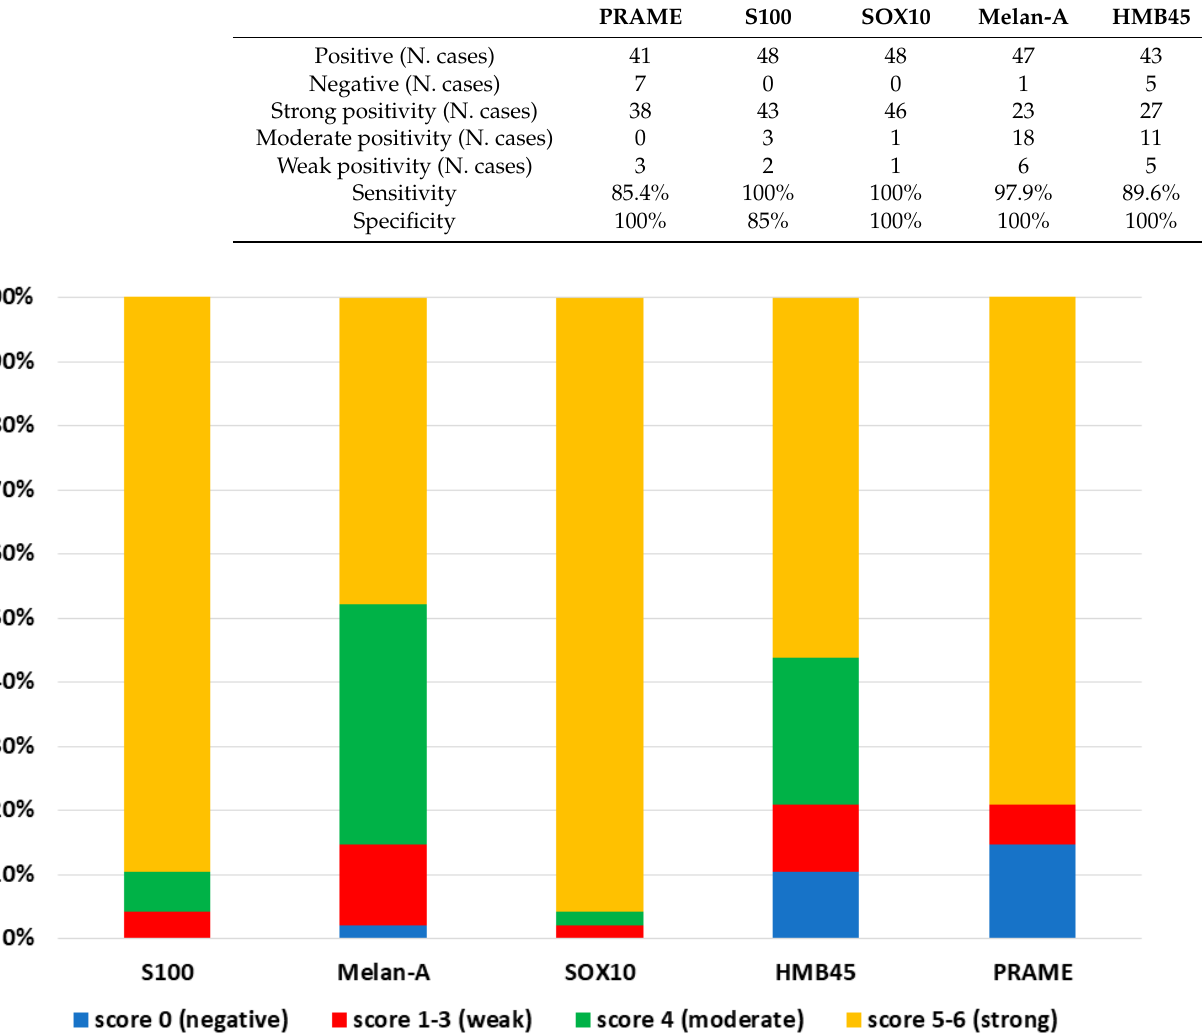
Table 1. Diagnostic performance of immunocytochemical markers.